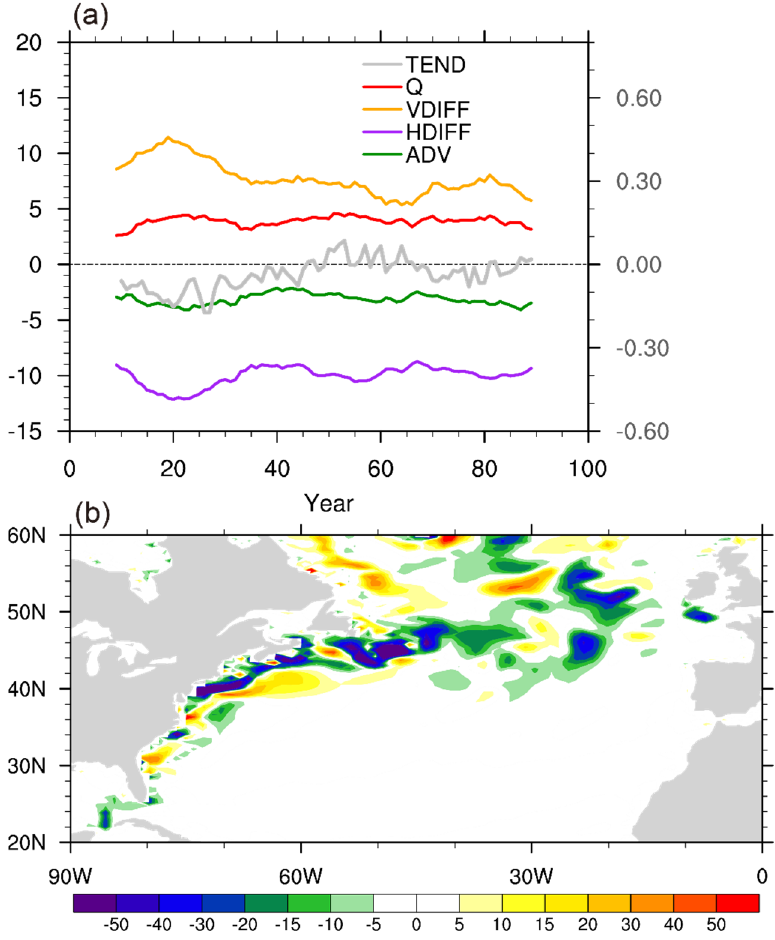
Figure 7. ( a ) Temporal evolutions of the heat budget terms in Equation (1). The grey curve is for the temperature tendency (TEND); green is for three-dimensional advection (ADV); purple is for the horizontal diffusion (HDIFF); orange is for the vertical diffusion (VDIFF); and red is for heat flux term (Q). The right y -axis is for TEND, and the left, for the other variables. The direction of Q is downward. All variables are averaged over the box of 42 ◦ –47 ◦ N, 20 ◦ –55 ◦ W, and 0–100 m. Unit: 10 − 8 ◦ C/s. ( b ) The temperature advection and horizontal diffusion anomalies (ADV + HDIFF) in the upper ocean in FOM. Unit: 10 − 8 ◦